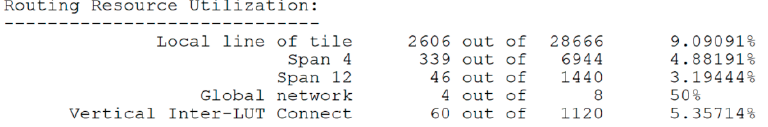
Figure 19. Synthesis Report—Logic Resource Utilization.